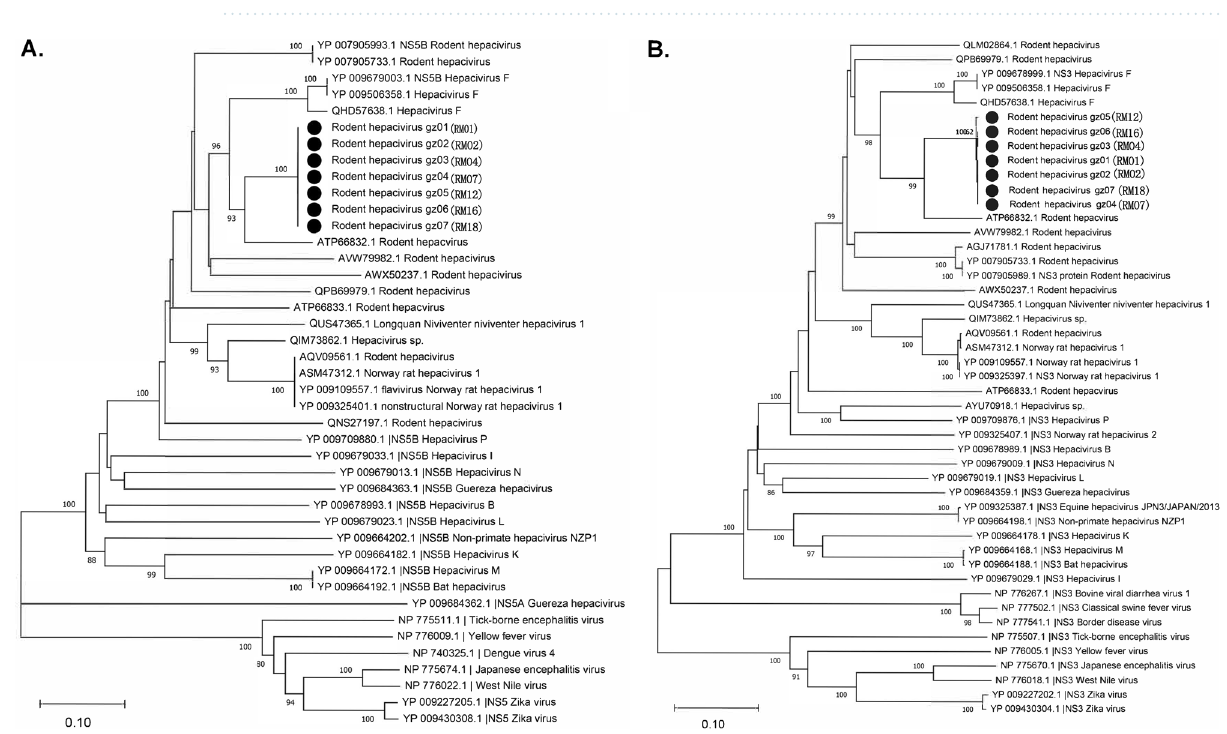
Figure 6. Phylogenetic analyses of hepacivirus variants based on the NS5B ( A ) and NS3 ( B ) protein. Branch lengths are drawn to a scale of aa substitutions per site. Numbers above individual branches indicate bootstrap support, only values > 80% are shown. Hepacivirus variants are marked by a black dot, sample ID were labeled in